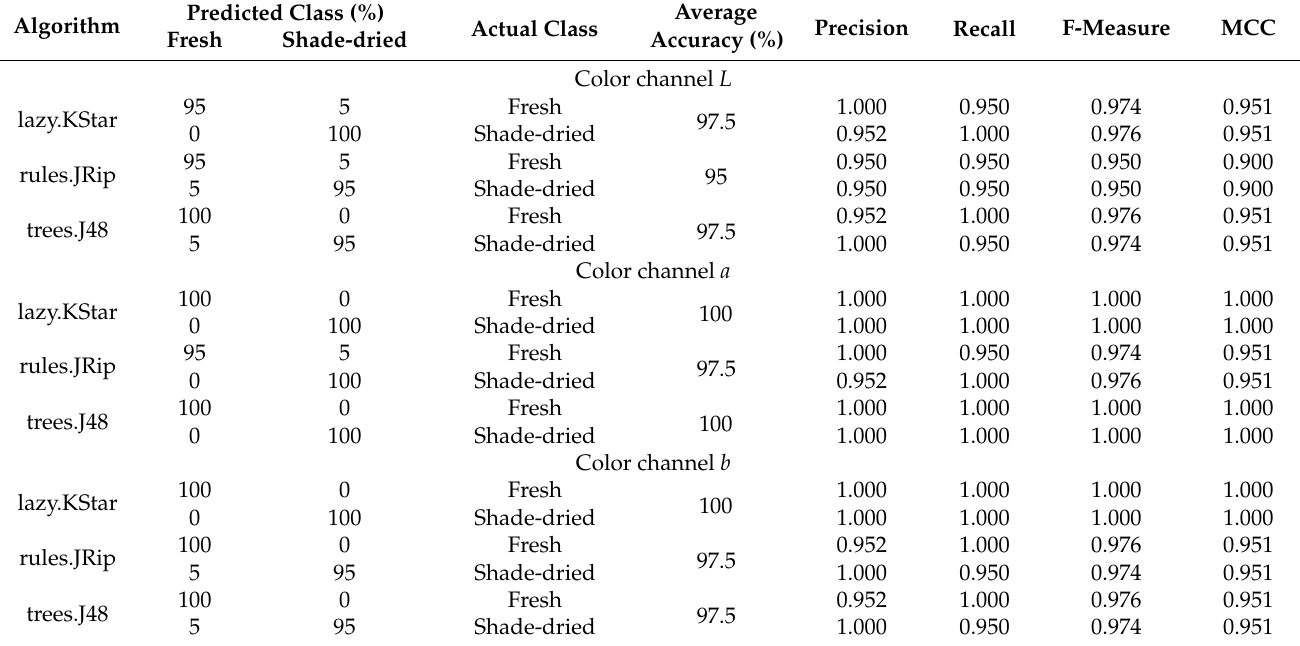
Table 2. The results of the classification of fresh and shade-dried mint leaves imaged on the ventral side using models built based on selected textures from color channels L , a, and b from color space